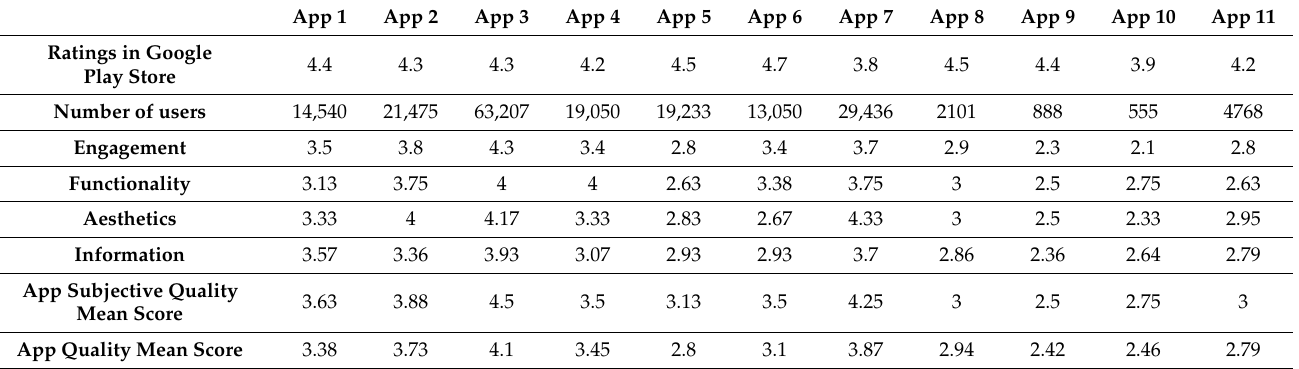
Table 6. Application values based on rating, number of users, mean score of ENGT, FUNT, AEST, INFN, and AQ, and the ASQ Mean Scores.